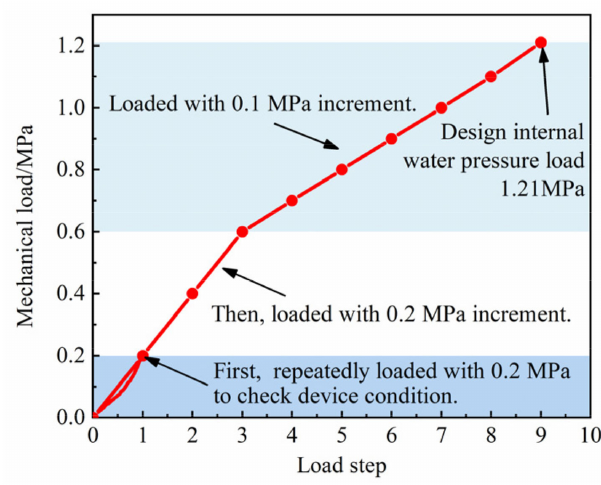
Figure 5. Loading device system.